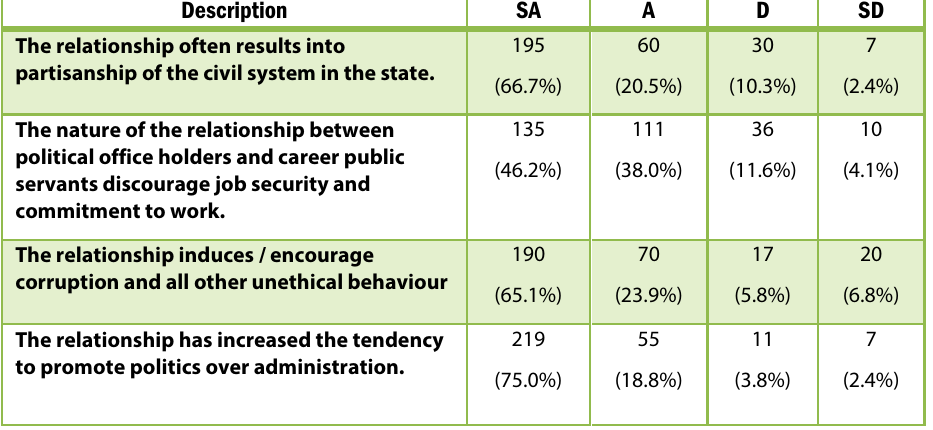
Table 3: Effect of the Interface on Public Service Ethos in Southwest Nigeria Description